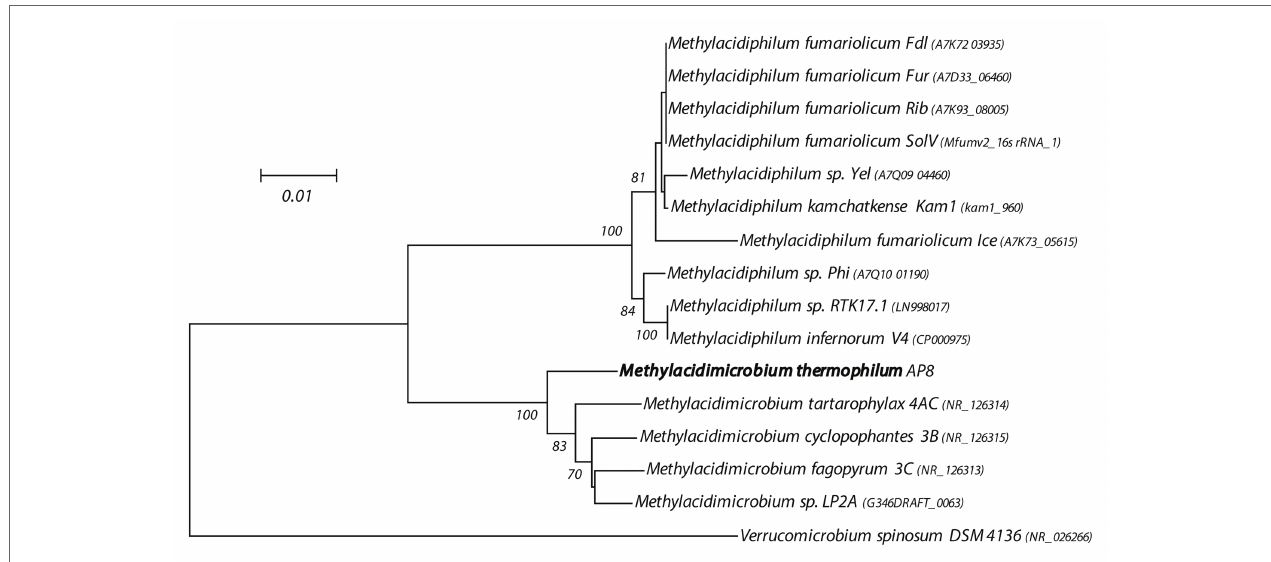
FIGURE 1 | 16S rRNA gene-based phylogenetic tree of methanotrophic Verrucomicrobia. The evolutionary history was inferred using the Neighbor-Joining method. The optimal tree with the sum of branch length = 0.21708868 is shown. The percentage of replicate trees (>60%) in which the associated taxa clustered together in the bootstrap test (500 replicates) are shown next to the branches. The tree is drawn to scale, with branch lengths in the same units as those of the evolutionary distances used to infer the phylogenetic tree. The evolutionary distances were computed using the Maximum Composite Likelihood method and are in the units of the number of base substitutions per site. The analysis involved 16 nucleotide sequences. All positions containing gaps and missing data were eliminated. There were a total of 1,393 positions in the final dataset. Evolutionary analyses were conducted in MEGA7 (Kumar et al.,